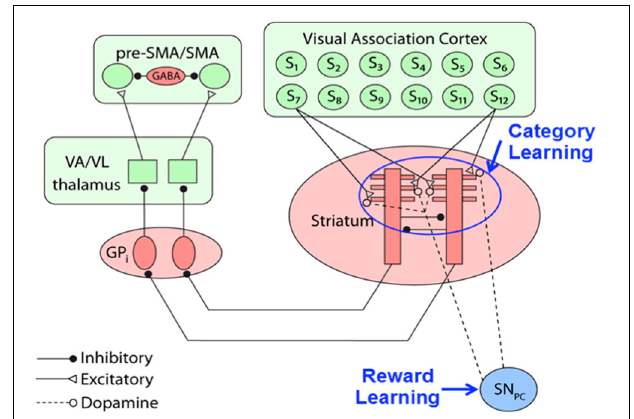
FIGURE 2 | Procedural category learning network. Dopamine release from the substantia nigra pars compacta ( SN PC ) leads to synaptic strengthening of cortical-striatal synapses activated by presentation of a visual stimulus, S i . (GP i , internal segment of the globus pallidus; VA/VL, ventral anterior/ ventral lateral nuclei of the thalamus; SMA, supplementary motor